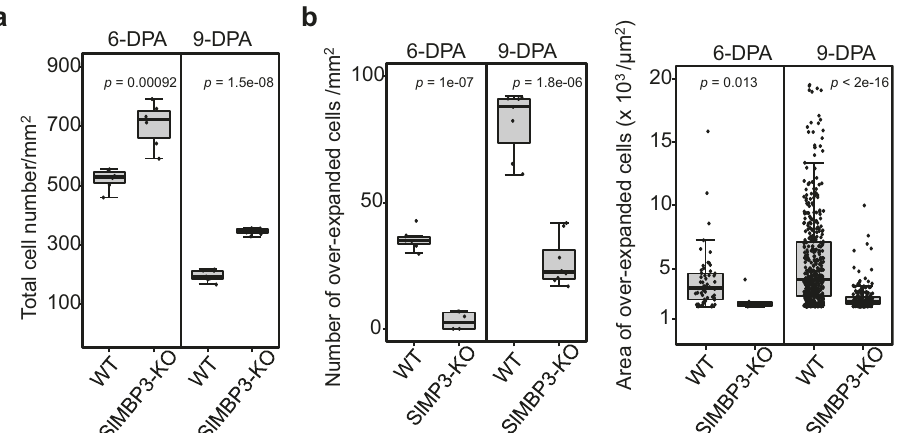
Fig. 8 Assessing the number and area of cell types in the locular tissue of WT and SlMBP3-KO fruit. a Quanti fi cation of the mean total number of cells including over-expanded fused cells per mm 2 of locular tissue at 6-DPA and 9-DPA. ( n = 16 – 21 ROIs contained in 6 – 8 fruits per stage coming from six individual plants for each genotype and in the case of SlMBP3-KO corresponding to two independent lines). Values are means± SD, and signi fi cance was determined by two-tailed Student ’ s t- test. b Quanti fi cation of the mean number of over-expanded and disintegrated cells per mm 2 of locular tissue at 6-DPA and 9-DPA (left panel) ( n = 18 – 21 ROIs contained in eight fruits per stage and per genotype). The right panel shows the measurement of the area of these individual cells at 6-DPA and 9-DPA ( n > 30 cells per stage and per genotype). Values are means± SD, and signi fi cance was determined by two- tailed Student ’ s t- test. Box edges represent the 0.25 and 0.75 quantiles, and the bold lines indicate median values. Whiskers indicate 1.5 times the interquartile range. Note that no measurement was performed at 3-DPA corresponding to the onset of a few locular gel cells in both genotypes. Source data are provided as a Source Data fi